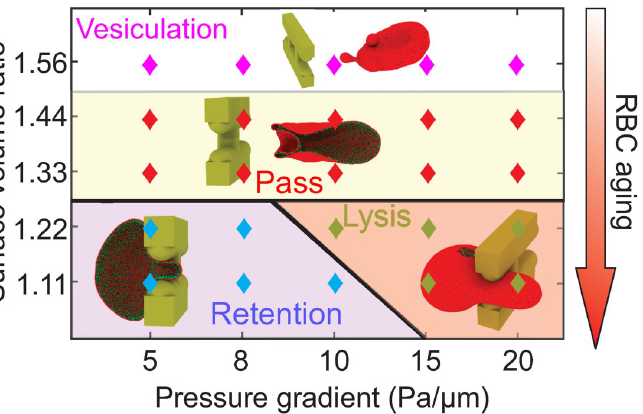
Fig 6. State diagram for RBC dynamics at IES driven by various pressure gradients and age-dependent RBC surface-to-volume ratios. Four states are observed. Red marks represent RBCs passing through IES. Pink marks represent the vesiculation of RBCs during their passage. Blue marks represent retention of RBCs by IES. Green marks represent lysis of RBCs at IES.